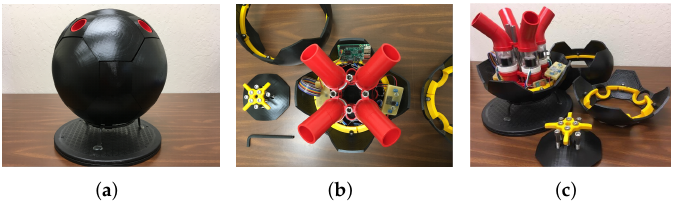
Figure 1. The first Wreck Interior Exploration Vehicle (WIEVLE) prototype: ( a ) WIEVLE on its test stand; ( b ) A top down view of the internal propulsion system. Note the central cavity where the RAATM may be installed; ( c ) WIEVLE’s spherical hull disassembled to reveal the internal propulsion